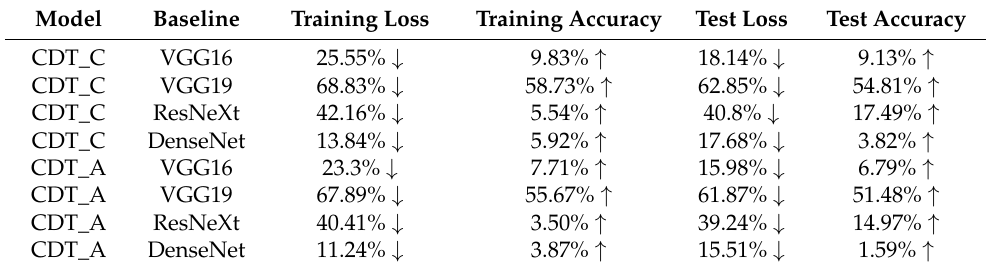
Table 2. Specific compared results on SVHN.